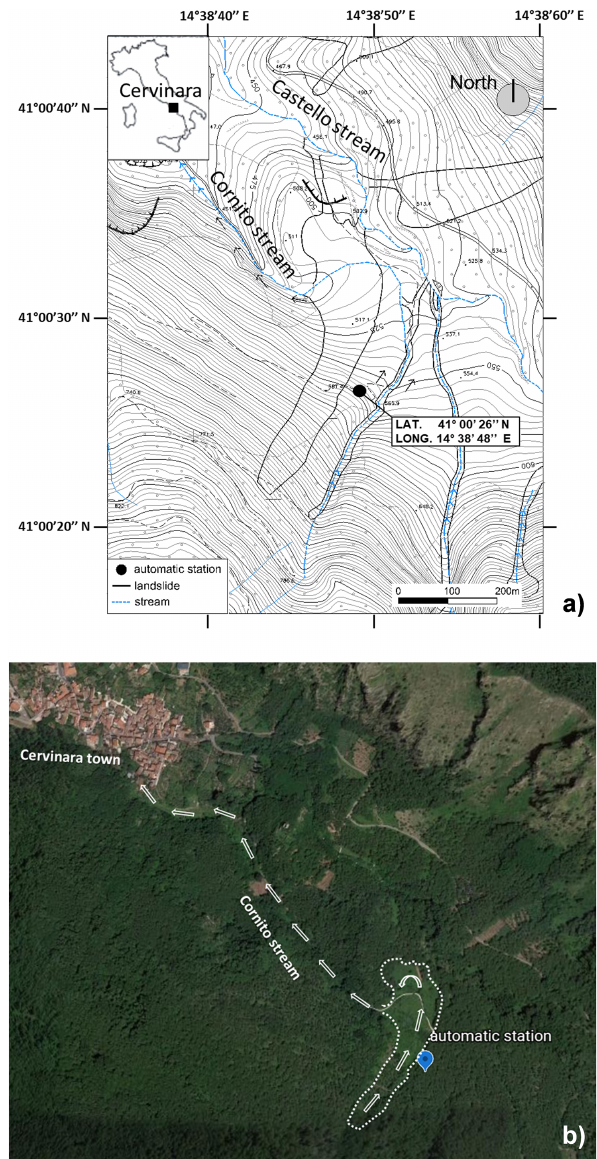
Figure 3. Location of the automatic monitoring station installed on the northeast facing slope of mount Cornito, 2km from the town of Cervinara (Campania Region, southern Italy): topographic map (a) and aerial photo of the site (b) . On 16 December 1999, the slope was involved in a flowslide that entered the narrow Cornito stream reaching the town downslope. Map (a) is provided by Damiano (2004). Aerial photo (b) is provided by © Google Earth